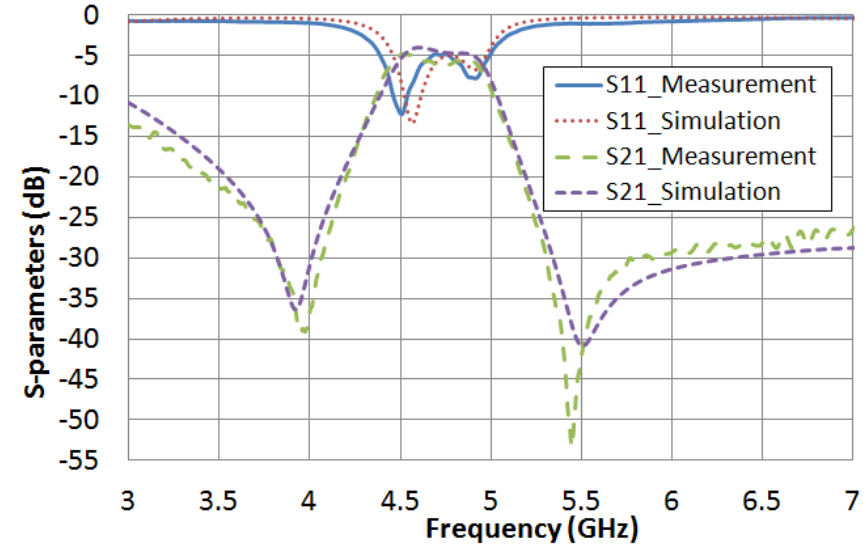
= 3.06 and tan δ = 0.02. r